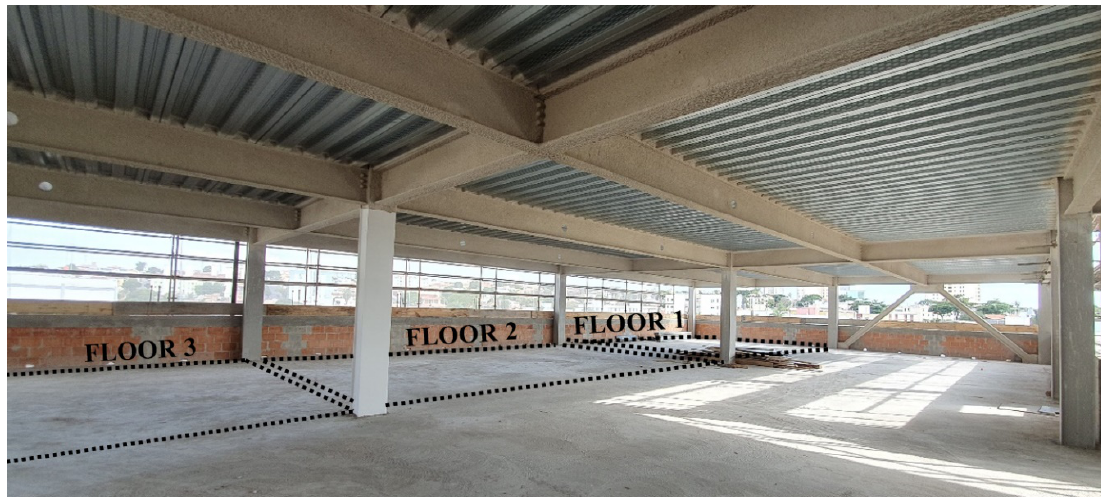
Figure 2. Identification of floors 1, 2 and 3 (Side A).